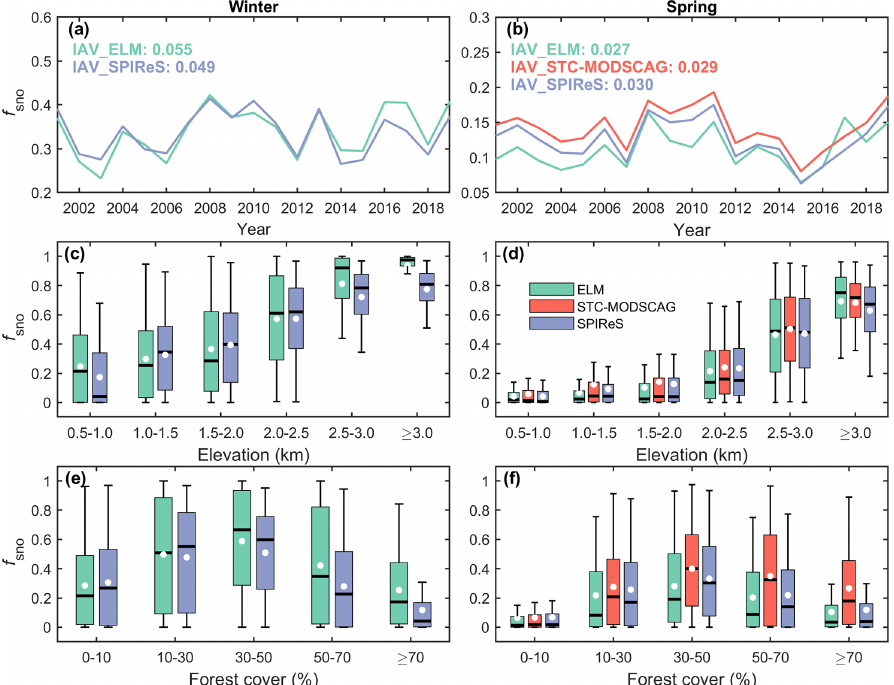
Figure 4. (a, b) Time series of regional average values, (c, d) elevation gradients, and (e, f) change with forest cover of snow cover frac- tion ( f sno ) in ELM (green), STC-MODSCAG (red), and SPIReS (blue) over the WUS. Panels (a, c, e) are for winter, and panels (b, d, f) are for spring. In panels (c–f) , the white dots represent the average values.